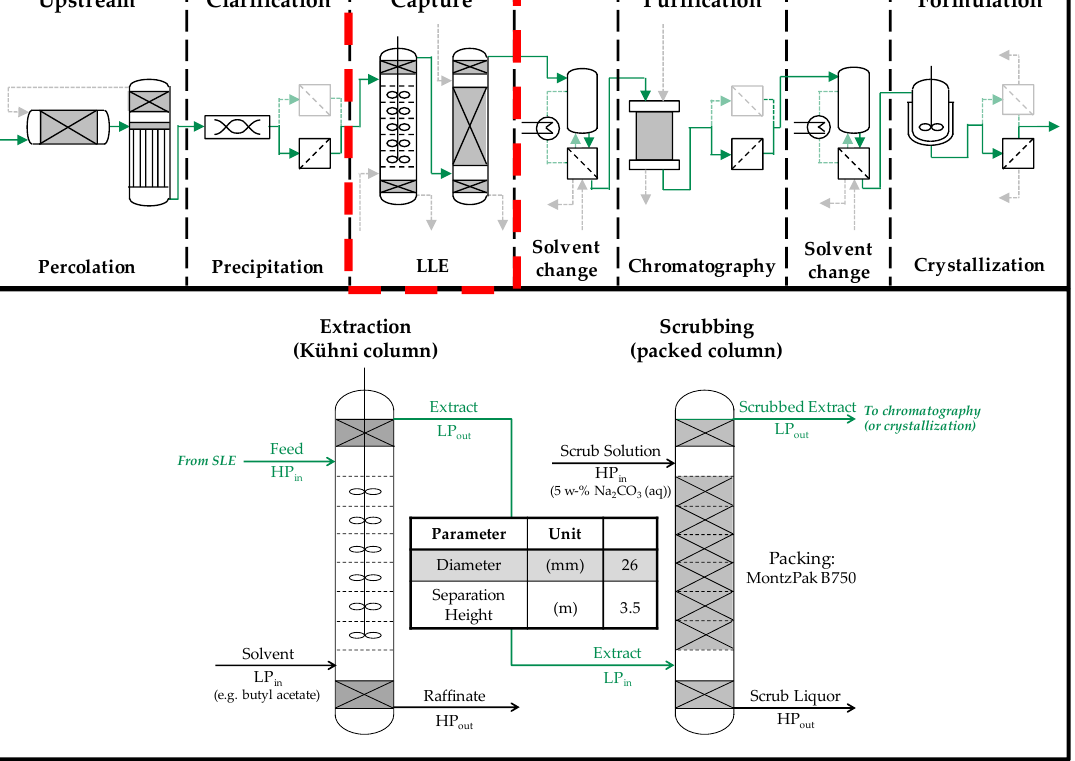
Figure 2. Overview of the investigated extraction columns and their position in the overall production chain. SLE (solid-liquid extraction), LLE (liquid-liquid extraction), LPin (light phase inlet), HPin (heavy phase inlet) LPout (light phase outlet), HPout (heavy phase outlet).